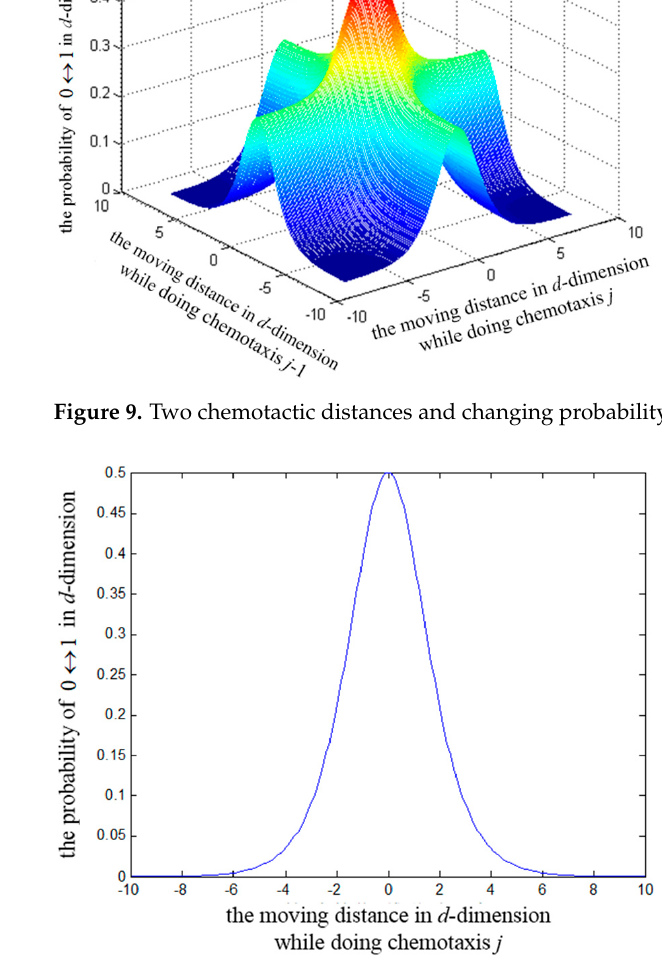
Figure 10. Chemotactic distances and position changing